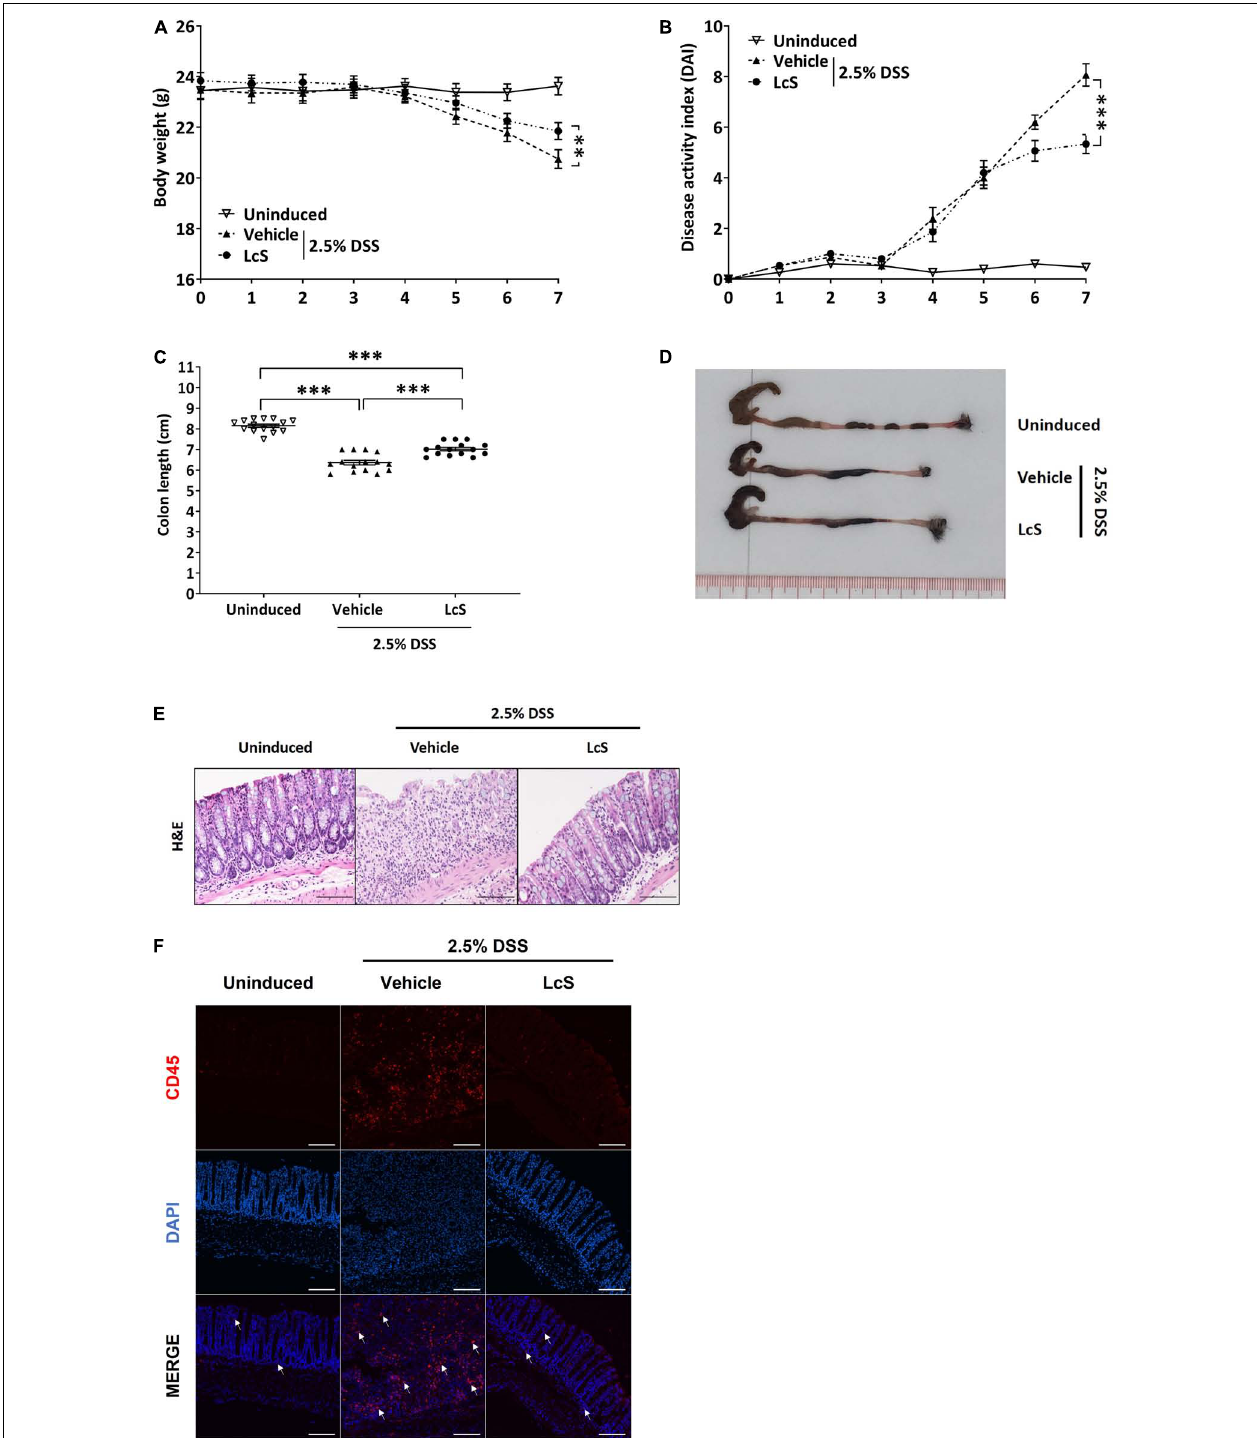
FIGURE 1 | LcS attenuated the severity of acute colitis in DSS-induced mice. Acute colitis was induced in C57BL/6J mice via administration of 2.5% DSS in drinking water. During the induction period, mice were fed orally with vehicle or LcS. Mice fed with normal drinking water and vehicle served as an uninduced group. Mice (A) body weight and (B) DAI were monitored daily. At the end of the experiment, mice were terminated and (C) colon lengths were measured. (D) Representative photographs of mice colons. (E) Representative H&E staining images of mice colons. (F) Representative images of CD45 immunofluorescence staining (red) in mouse colons. White arrows indicate positive stain. Data are expressed as mean ± SEM; ∗∗ p < 0.01, ∗∗∗ p < 0.001. Scale bars: H&E, 50 µ m; immunofluorescence staining, 25 µ m.